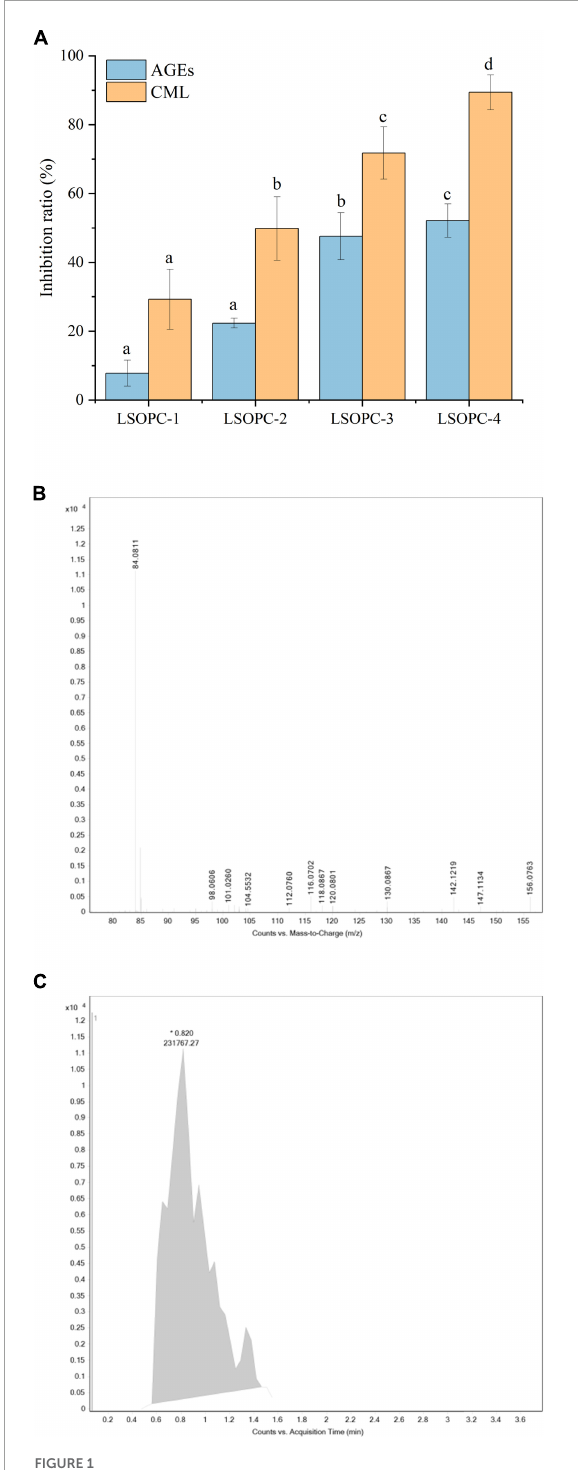
FIGURE1 Effect of different concentrations of LSOPC on inhibition rate of AGEs and CML in cookies (A) . Ion spectra of the standard substance CML (B) . Peak area of the standard substance CML (C) . Significant differences ( p < 0.05) of data values were indicated by different